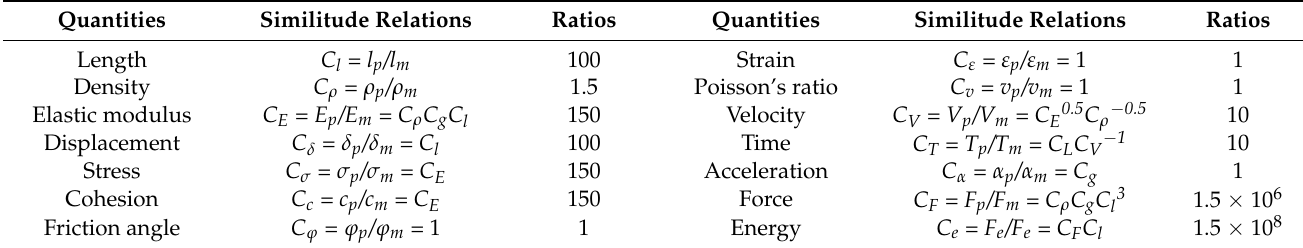
Table 2. Similarity proportions of the physical quantities for physical model.